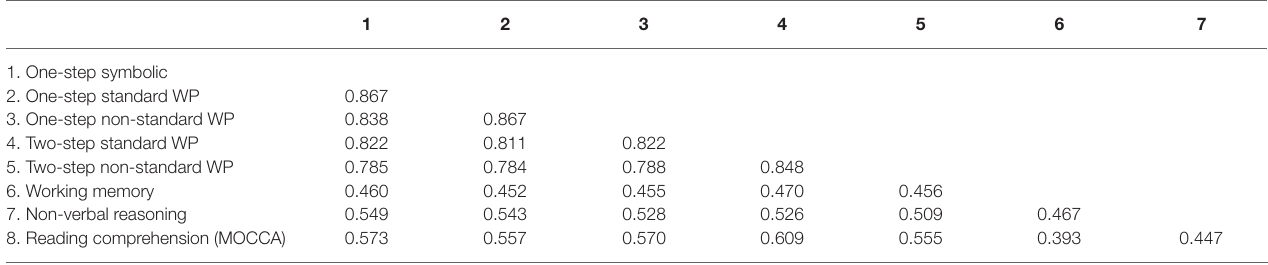
TABLE 3 | Correlations between the